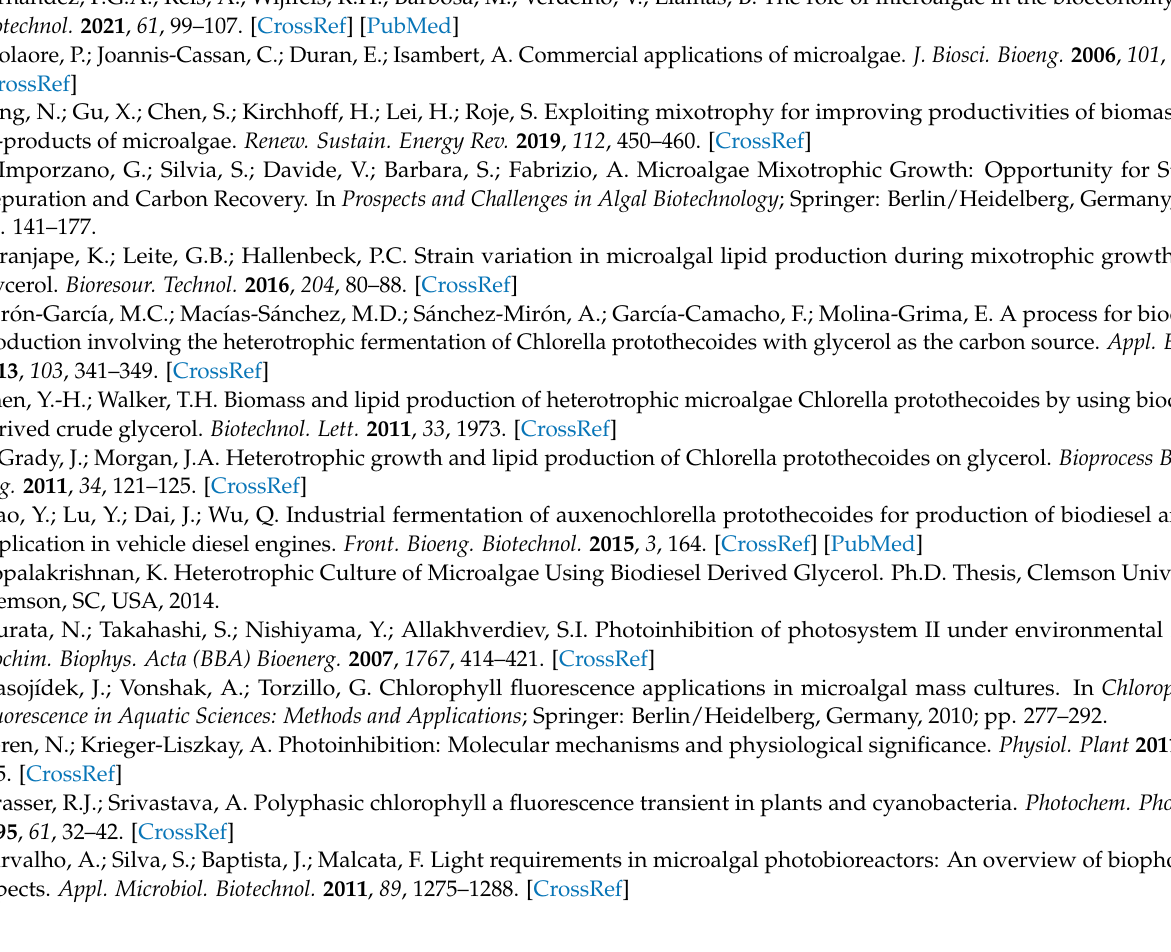
Figure A2. Spectra of the LEDs used for the illumination of the cultures of A . protothecoides and the associated absorption of the photosynthetically active pigments (chlorophyll a , chlorophyll b , and carotenoids).